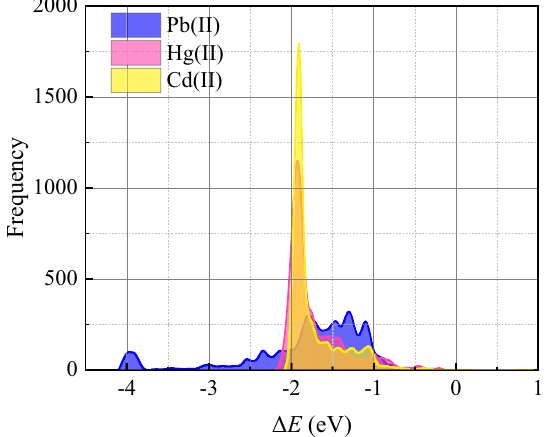
Fig. 5 Overall comparison. Three histograms of g-C 3 N 4 towards Pb (II), Hg(II) and Cd(II) with 7000 calculated Δ E by DFT, 700 calculated Δ E by DFT + 6300 predicted Δ E by TL, and 700 calculated Δ E by DFT + 6300 predicted Δ E by TL, where the adsorption energies of Pb(II) on the surface of g-C 3 N 4 distributed between − 4.144 eV and − 0.07 eV, while the adsorp- tion energies of Hg(II)/g-C 3 N 4 and Cd(II)/g-C 3 N 4 are distributed between − 2.136 eV and − 0.139 eV, and − 2.048 and − 0.051 eV,